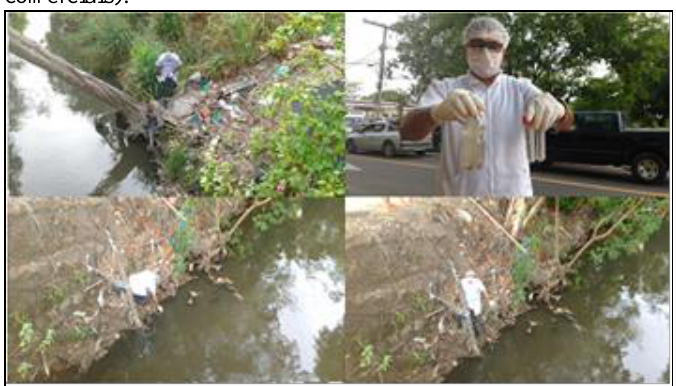
Figura 5: Igarapé do quarenta no bairro Japiim. Fonte: Autores, (2018).